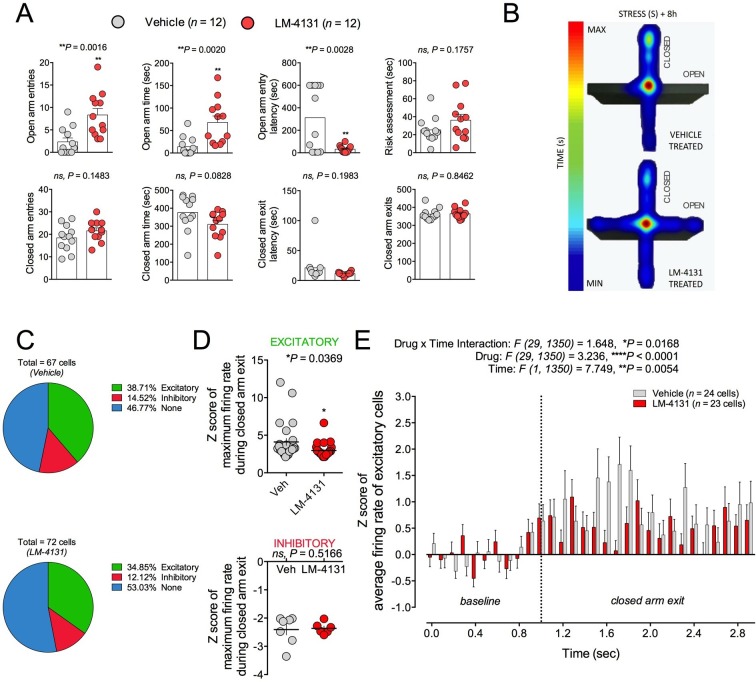
Effects of COX-2 inhibition on in vivo activity of BLA neuronal activity.(A) LM-4131 decreases latency to enter and increases entries into and time spent in the open arms of the EPM 8 hr following stress exposure. (B) Representative heat maps of time spent in the closed (vertical) versus open (horizontal) arms of the EPM. (C) Percentage of total cells recorded that were responsive upon exiting a closed arm. (D) LM-4131 reduced the maximum firing rate of cells responsive to closed arm exit, but had no effect on cells inhibited by closed-arm exit. (E) LM-4131 reduced the increase in average firing rate following closed arm exit in responsive cells. *p<0.05, **p<0.01 by two-tailed unpaired t-test. F and P values for two-way ANOVA shown in (E).